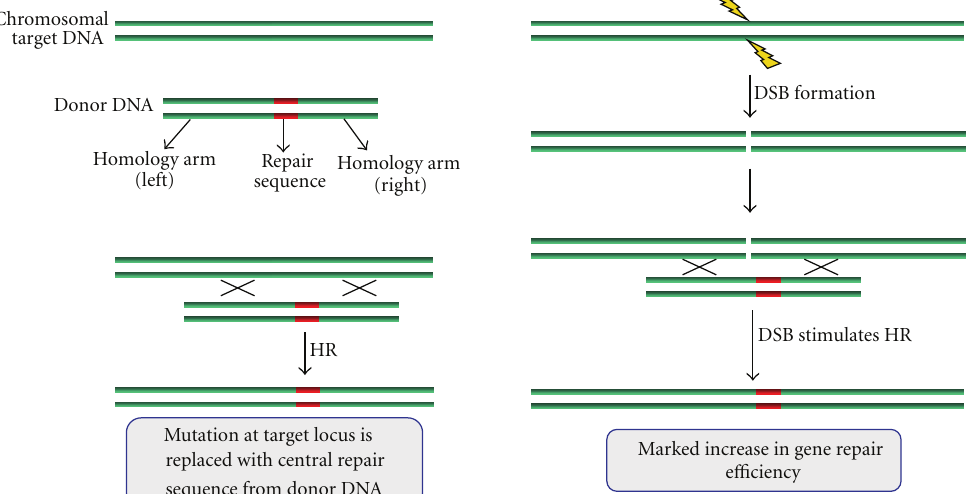
Figure 5: Double-strand breaks (DSBs) stimulate homologous recombination (HR) repair. HR facilitates exchange of DNA sequence between donor and acceptor molecules, provided they share a certain amount of sequence similarity. Donor DNA molecules are designed to contain a central “repair” sequence, flanked by “homology” arms, whose sequence is identical to that of the acceptor (e.g., genomic) DNA. Through HR, the repair sequence replaces the entire sequence lying between the crossover points (marked with an X) on the acceptor. Gene targeting exploits HR in this way to make genetic changes to a cell’s DNA. Importantly, introduction of a DSB into the acceptor sequence, which can be achieved by adding an engineered nuclease with locus-specific cleavage (see Figure 6), markedly increases gene repair e ffi